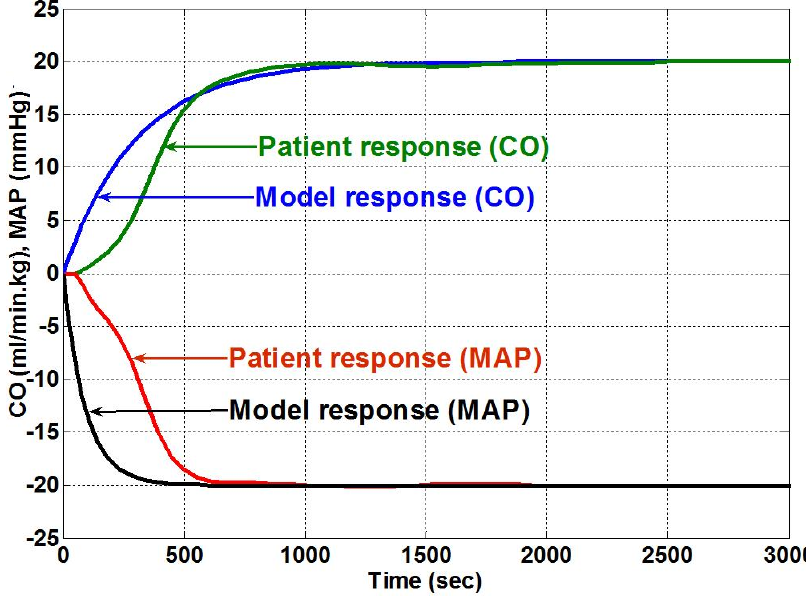
Figure 5: Patient response (CO and MAP) without disturbance, when K 22 =